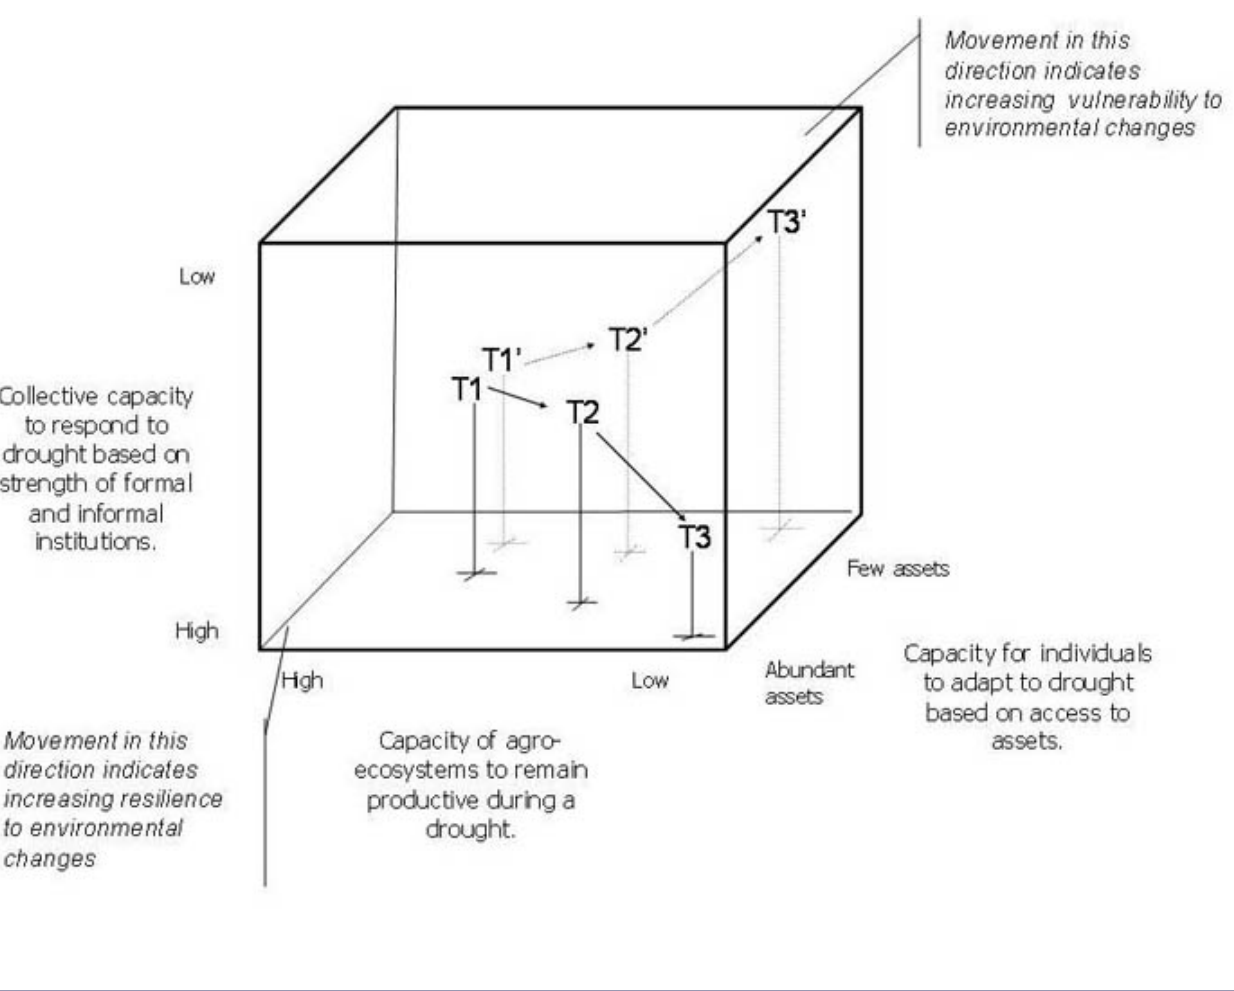
Fig. 3 . Heuristic depiction of changing levels of vulnerability to drought for southern Botswana pastoralists over the past 30 years. T1, T2, and T3 refers to wealthy ranchers who raise cattle on private land. T1’, T2’ and T3’ refer to poorer pastoralists on communal